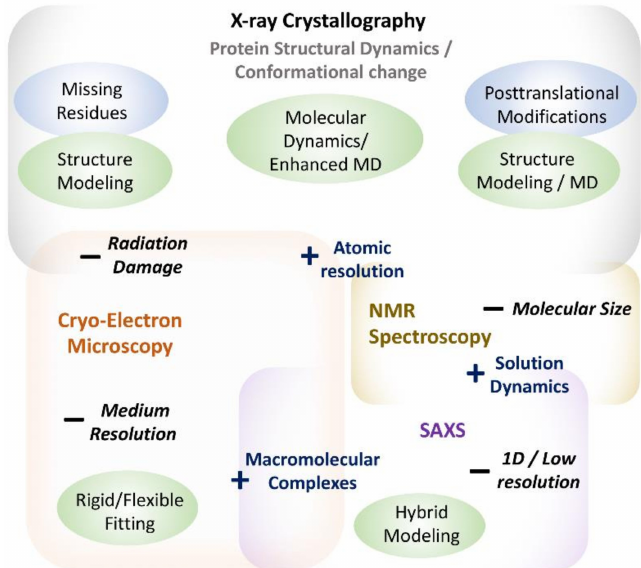
Figure 1. Summative figure showing strengths and limitations of various experimental methods in understanding protein structure and dynamics. MD stands for Molecular Dynamics. Different boxes represent different experimental methods with “+” sign showing their strengths and “ − ” sign showing their limitations. Computational methods addressing the limitations are shown in green